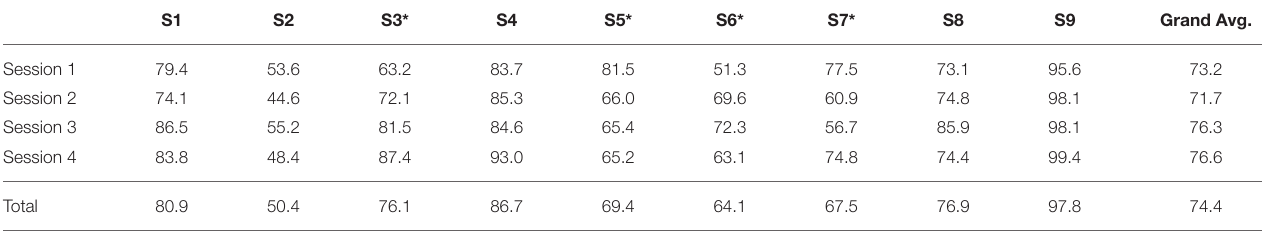
TABLE 1 | Online performance.